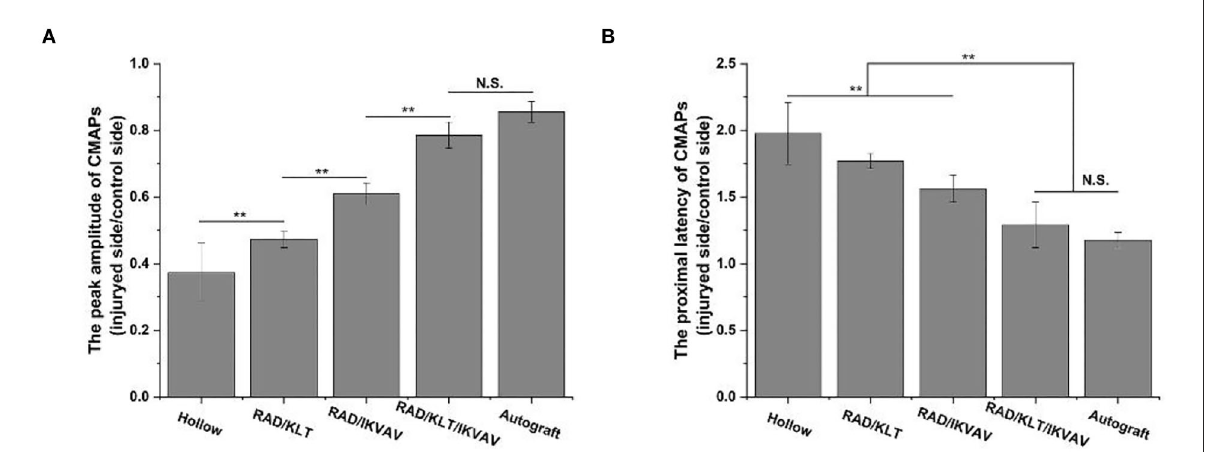
FIGURE7 (A) The peak amplitude of CMAPs of the regenerated nerves. (B) The proximal latency of CMAPs. Values represent mean ± SD; N.S. no significant difference, ** p < 0.01, * p < 0.05 in multiple comparisons between treatment